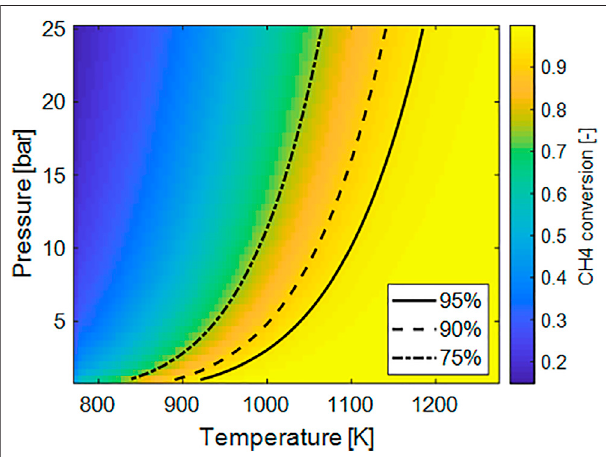
FIGURE 2 | Plot of the equilibrium methane conversion as a function of temperature and pressure for concentrated stream and S/C (cid:2) 4.